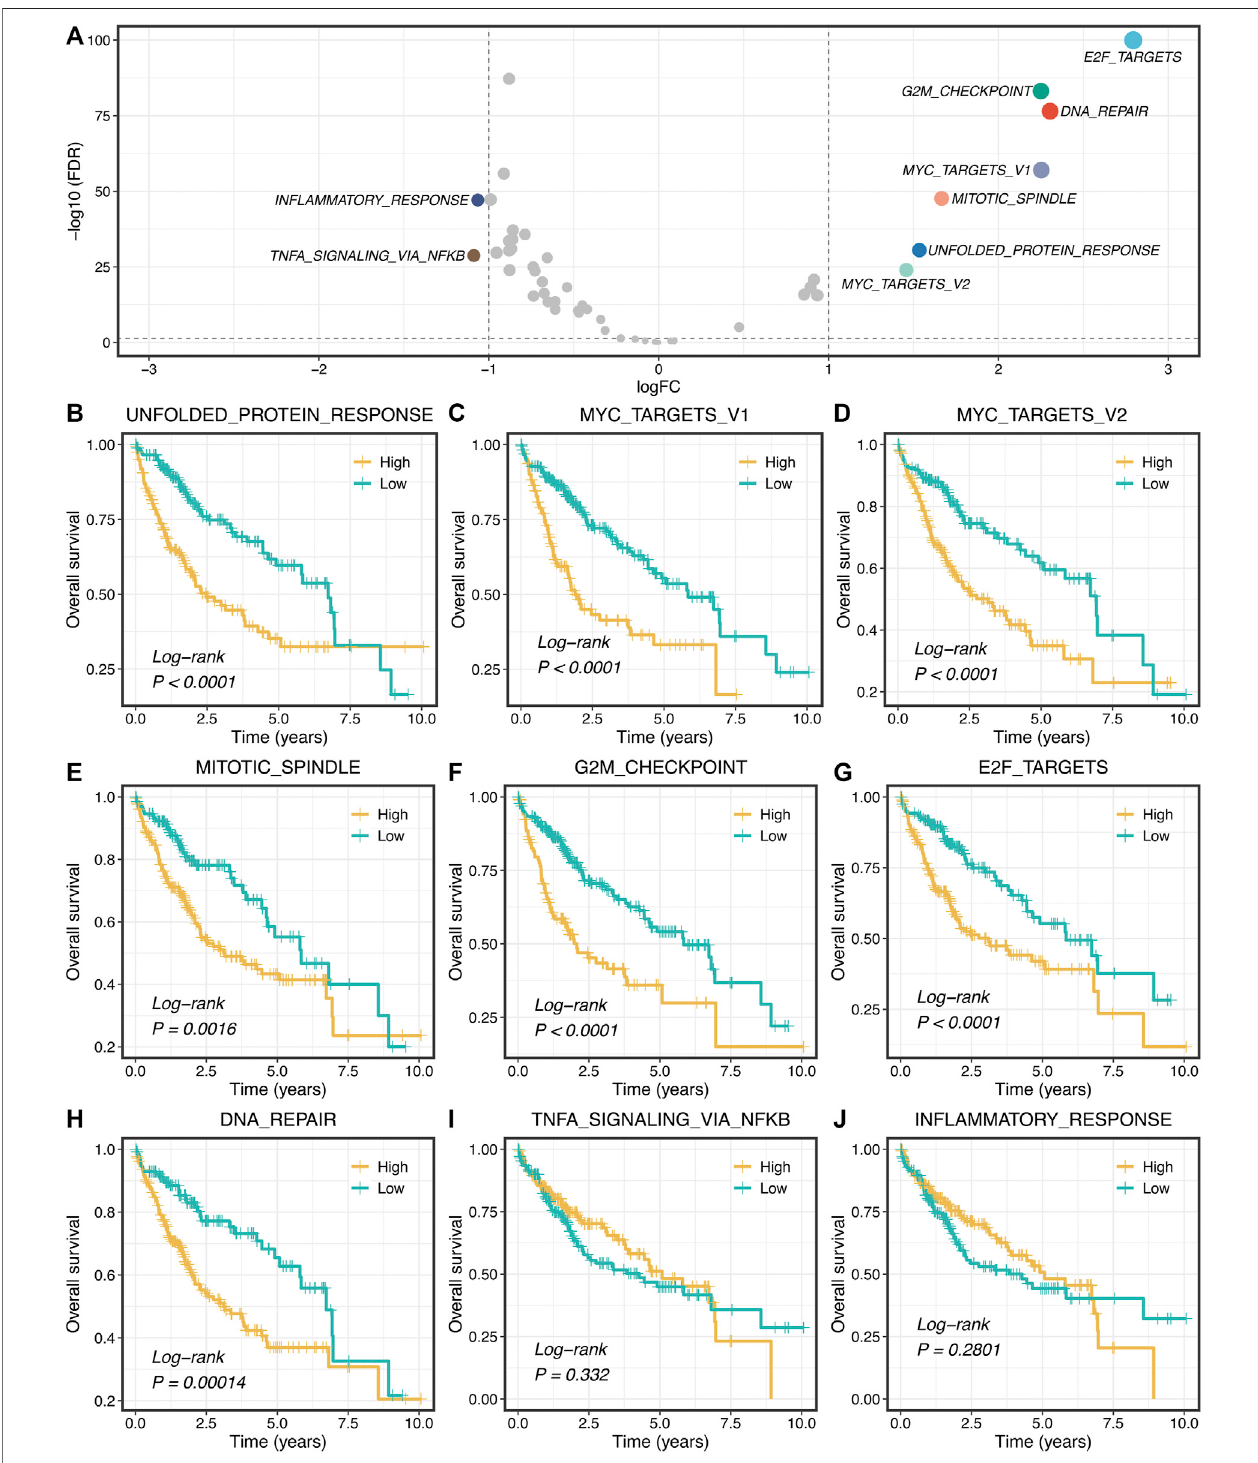
FIGURE 1 | Proliferation pathways upregulated and correlated with a worse prognosis. (A) Differential analysis of the activity variation of fi fty Hallmark gene sets between tumor and normal samples. (B – J) Kaplan-Meier plots of OS based on the activities of nine pathways.